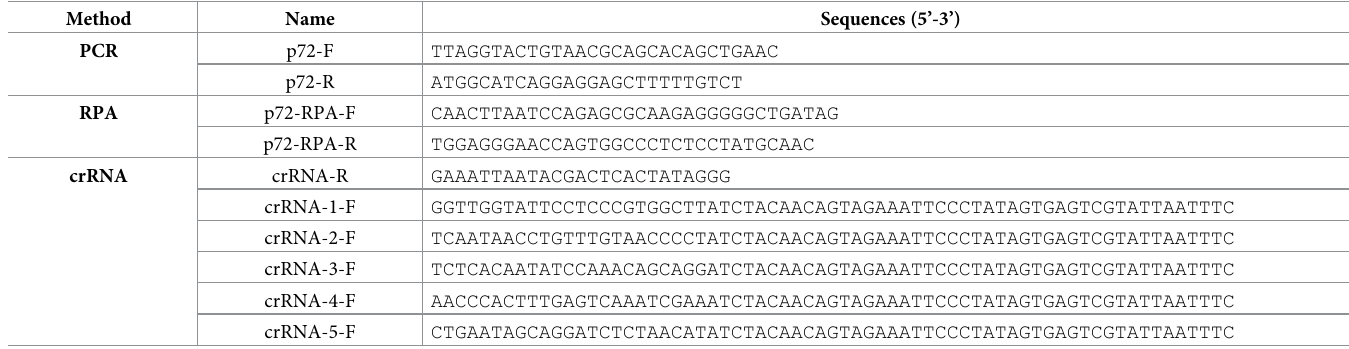
Table 1. Primers and crRNA used in this